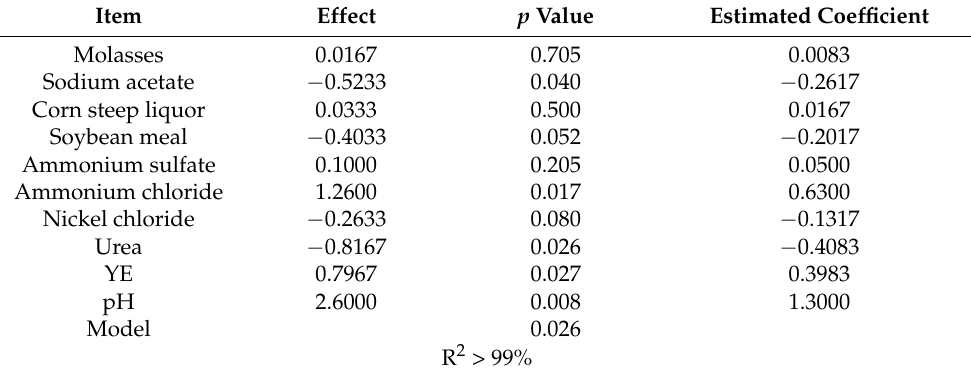
Table 4. Results of PB